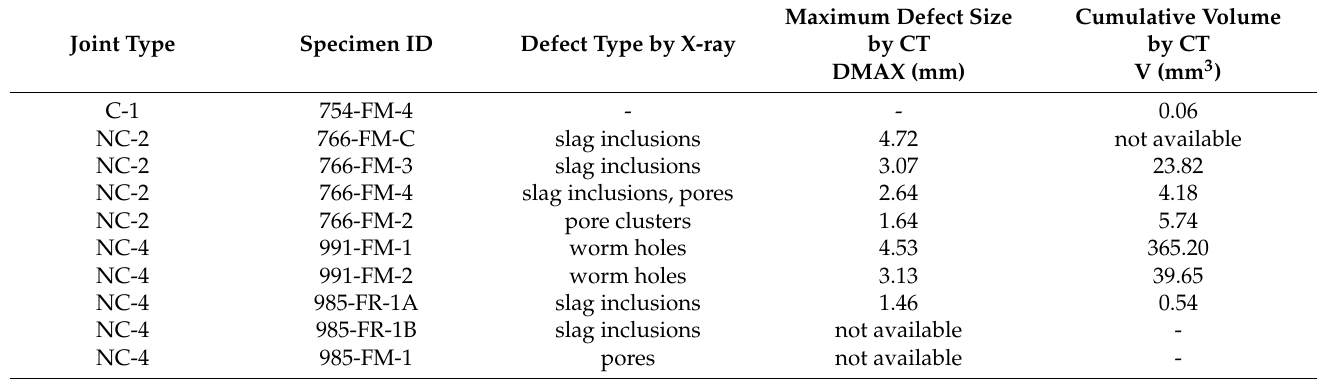
Table 4. Defect parameters evaluated by computed tomography (CT).